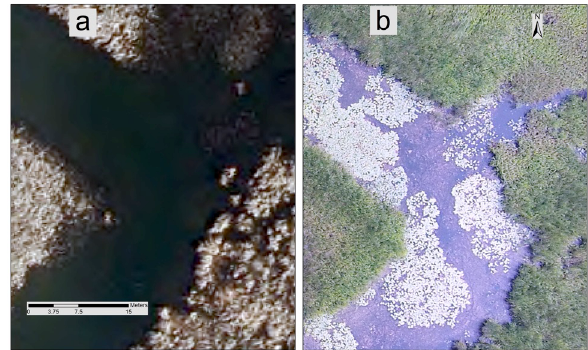
Figure 5: Comparison of a) SWOOP imagery with b) UAV- acquired imagery. Notice details associated with the floating and submersed aquatic vegetation in (b) that is absent in